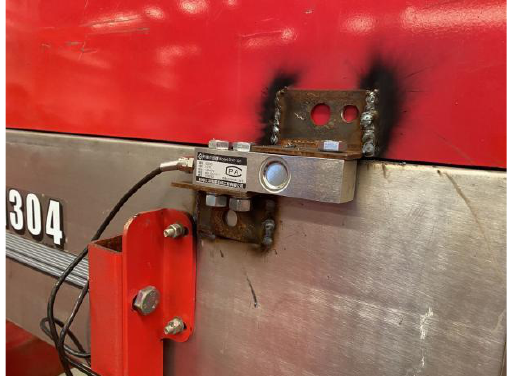
Figure 4. Pressure sensor installation diagram.